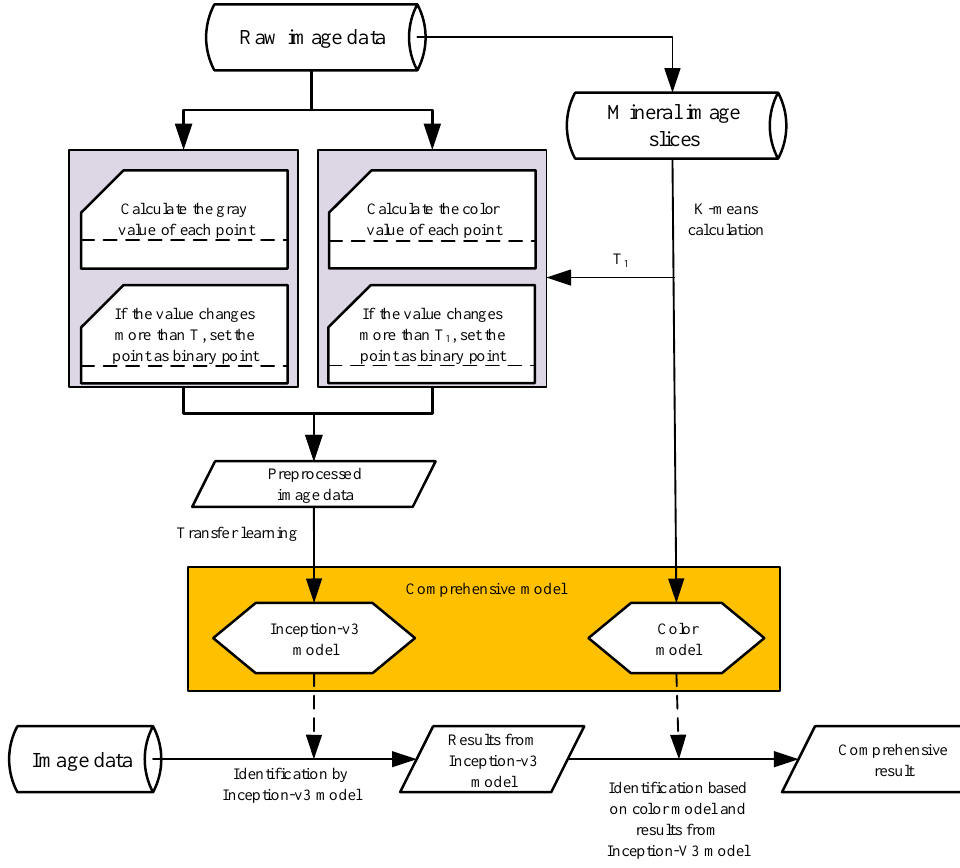
Figure 1. The training process and identification process of a comprehensive model.